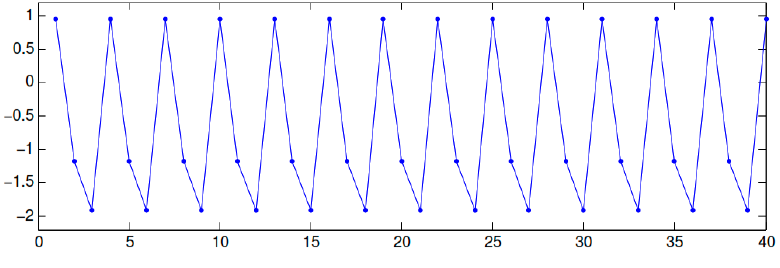
Figure 3. Prime period three solutions of Equation